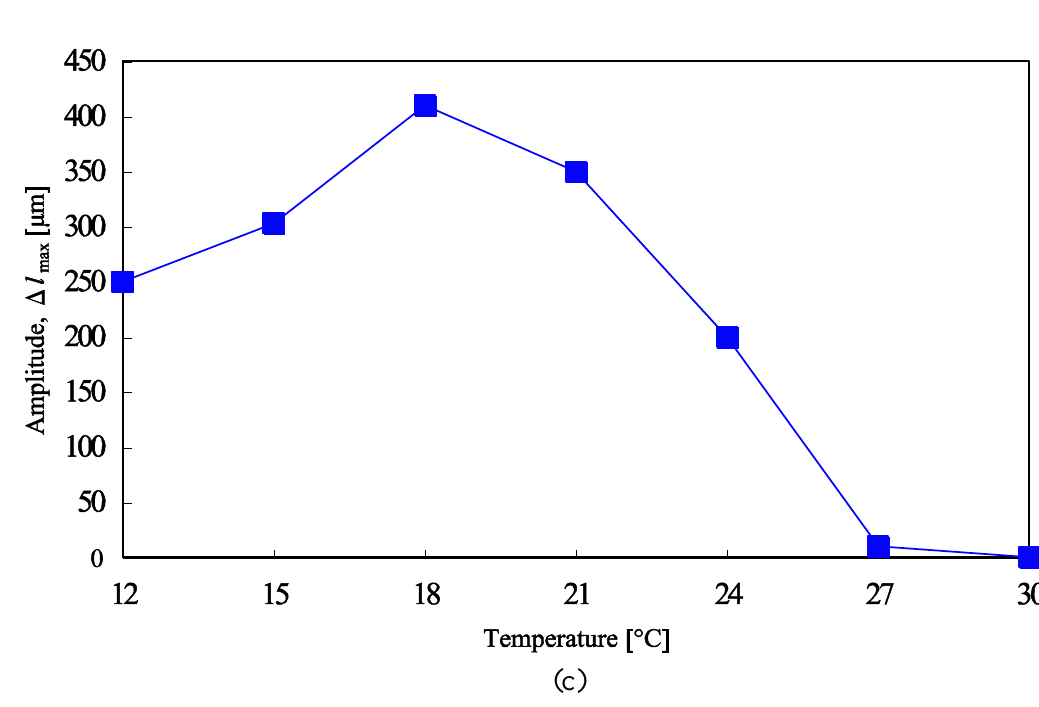
Figure 2. ( a ). Surface structure of the ratchet floor made of acrylic sheet. ∆a stands for